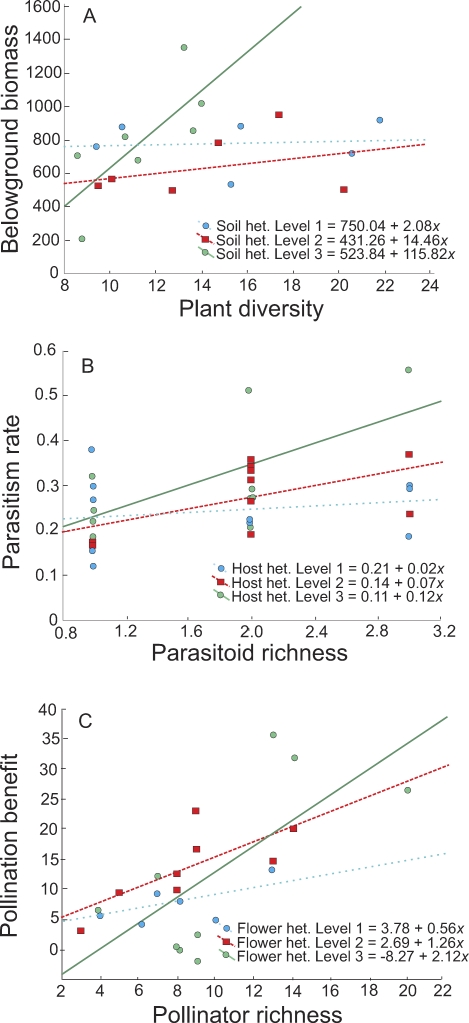
The Slope of the BDEF Relationship Increases with Increasing Resource HeterogeneityIn all graphs, the slope of the diversity-function relationship increases with increasing levels of resource heterogeneity. As heterogeneity measures were continuous variables, separation into three categories (1, 2, and 3, representing low, medium, and high heterogeneity, respectively) was necessarily arbitrary. There were an equal number of replicates per heterogeneity level, plus or minus 1 when the number of replicates could not be divided evenly by 3. Equations for the BDEF relationship at each level of heterogeneity are presented with each figure. Both diversity and the interaction between diversity and heterogeneity were significant predictors of the ecosystem function.(A) Relationship between plant diversity (i.e., Shannon-index), soil heterogeneity (Factor 5 from PCA on the CV in soil chemical concentrations), and standing root biomass (dry weight g/m2).(B) Relationship between parasitoid species richness, heterogeneity in host (Pseudodynerus sp.) abundance, and rates of parasitism. Heterogeneity in host abundance was calculated as the CV between the nine sampling points per plot. Parasitism rates are the proportion of host larvae parasitized (arcsine square root transformed).(C) Relationship between pollinator species richness, heterogeneity in flower density, and pollination benefit (difference between percent fruit set in open and bagged control treatments). Flower heterogeneity was calculated as the CV in flower abundance between the three experimental coffee shrubs.